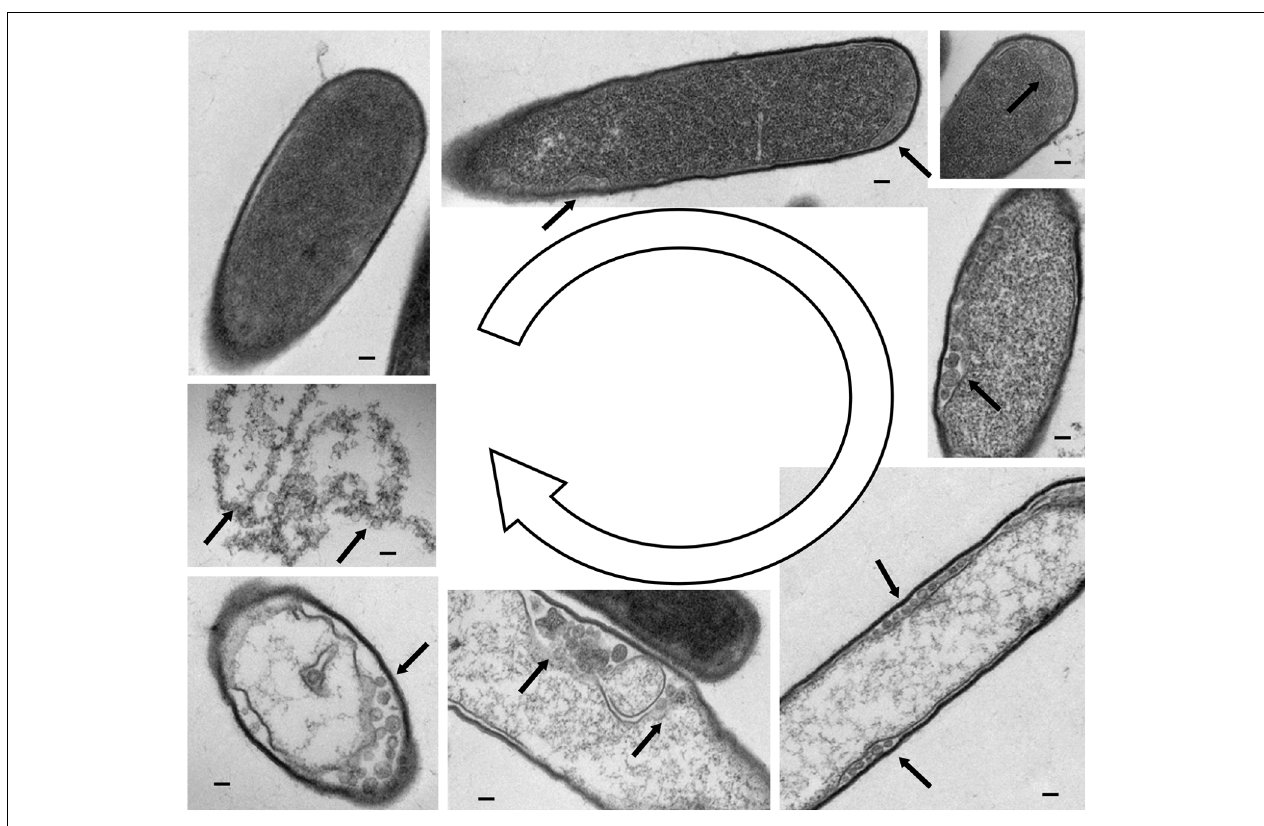
FIGURE 1 | Lysis of C. difficile cells by myovirus phiCDHM1. Transmission electron microscopy on microtomed samples showing various stages of the phage lytic cycle. Clockwise from top left, a cell with a single attached virion. Photomicrographs show an increasingly granular appearance inside the cell, and the formation of putative capsid